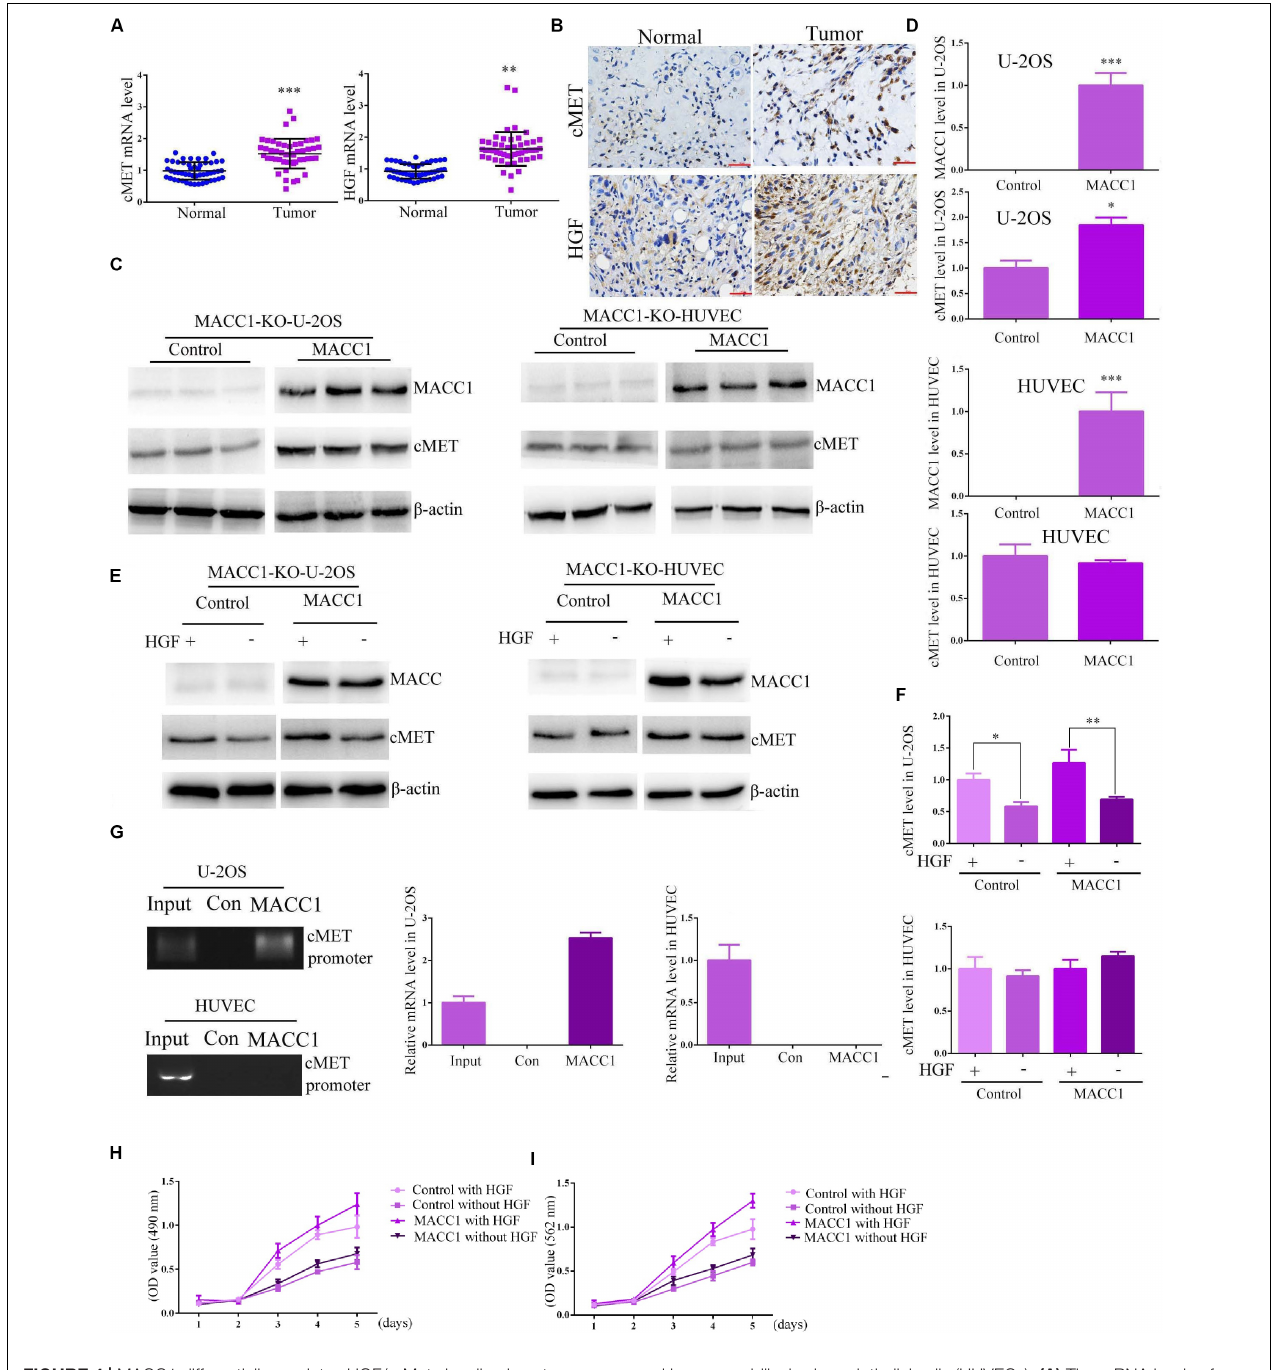
FIGURE 4 | MACC1 differentially regulates HGF/c-Met signaling in osteosarcoma and human umbilical vein endothelial cells (HUVECs). (A) The mRNA levels of c-Met (left) and HGF (right) in tumor tissues and the corresponding adjacent noncancerous tissues collected in our hospital ( n = 30). (B) Representative immunohistochemistry images of c-Met and HGF expression. The expression level was compared between normal and tumor tissues. (C) MACC1-knockout U-2OS cells and HUVECs were transfected with pcDNA3.1-MACC1 or pcDNA3.1-empty vector plasmids, and the expression levels of MACC1 and c-Met were measured through immunoblot assays, followed by quantification of relative protein levels (D) . (E) HGF induced the expression of c-Met in U-2OS cells, but not in HUVECs. MACC1-knockout U-2OS cells and HUVECs were transfected with pcDNA3.1-MACC1 or pcDNA3.1-vector plasmids, and then treated with 100 ng of HGF for 24 h. The expression levels of MACC1 and c-Met were measured through immunoblot assays, followed by quantification of relative protein levels (F) . (G) ChIP assays were performed to investigate whether MACC1 could bind to the promoter region of c-Met in U-2OS cells and HUVECs. A visible band was observed in U-2OS cells, but not HUVECs, following MACC1 plasmid transfection. Relative ratios of IP DNA to input DNA were determined by ChIP-PCR. (H) CCK-8 assays were performed upon the indicated treatment in U-2OS cells. (I) MTT assays were performed upon the indicated treatment in U-2OS cells. Results are presented as means ± SEM; ∗∗ p < 0.01 and ∗∗∗ p <